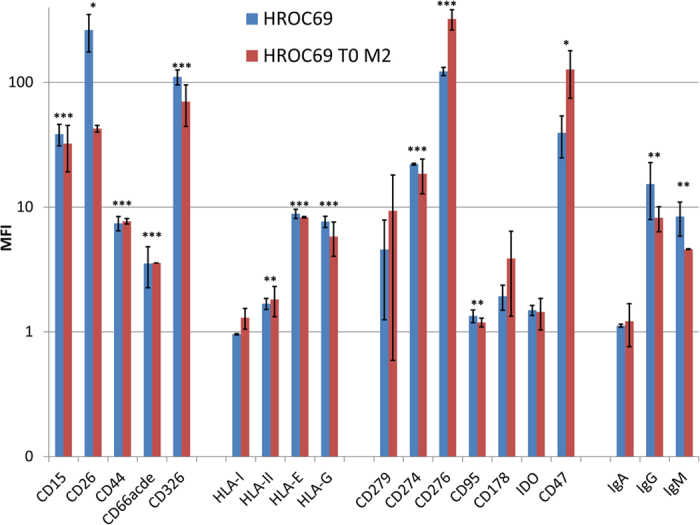
Expression of HLA molecules, immune checkpoint proteins and CRC markers.Expression of epithelial tumour markers (CD15, CD26, CD44, CD66acde and CD326), HLA molecules (HLA-I, HLA-II, HLA-E and HLA-G), immune checkpoints (CD279, CD274, CD276, CD95, CD178, IDO and CD47) and immunoglobulins (IgA, IgG and IgM) was assessed by flow cytometry using a BD FACSARIA II. Mean fluorescent intensity (MFI = (fluorescence intensity of antibody staining-fluorescence intensity of control)/ fluorescence intensity of control) ± SEM of n = 3 analyses are represented in the bar chart for the patient-derived cell line (HROC69, blue) and the PDX-derived cell line (HROC69 T0 M2, red).